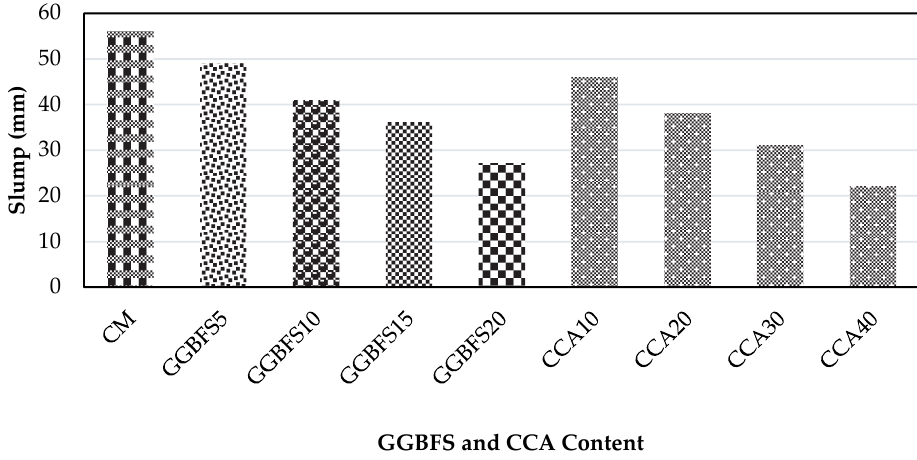
Figure 4. Slag slump tests of fresh concrete containing GGBFS and CCA.